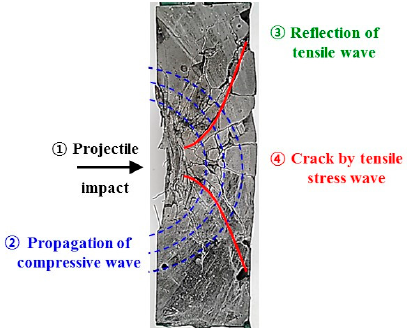
Figure 1. Damage regions and propagation of the elastic stress wave in the concrete subjected to impact forces. Table 1. Empirical formulae.